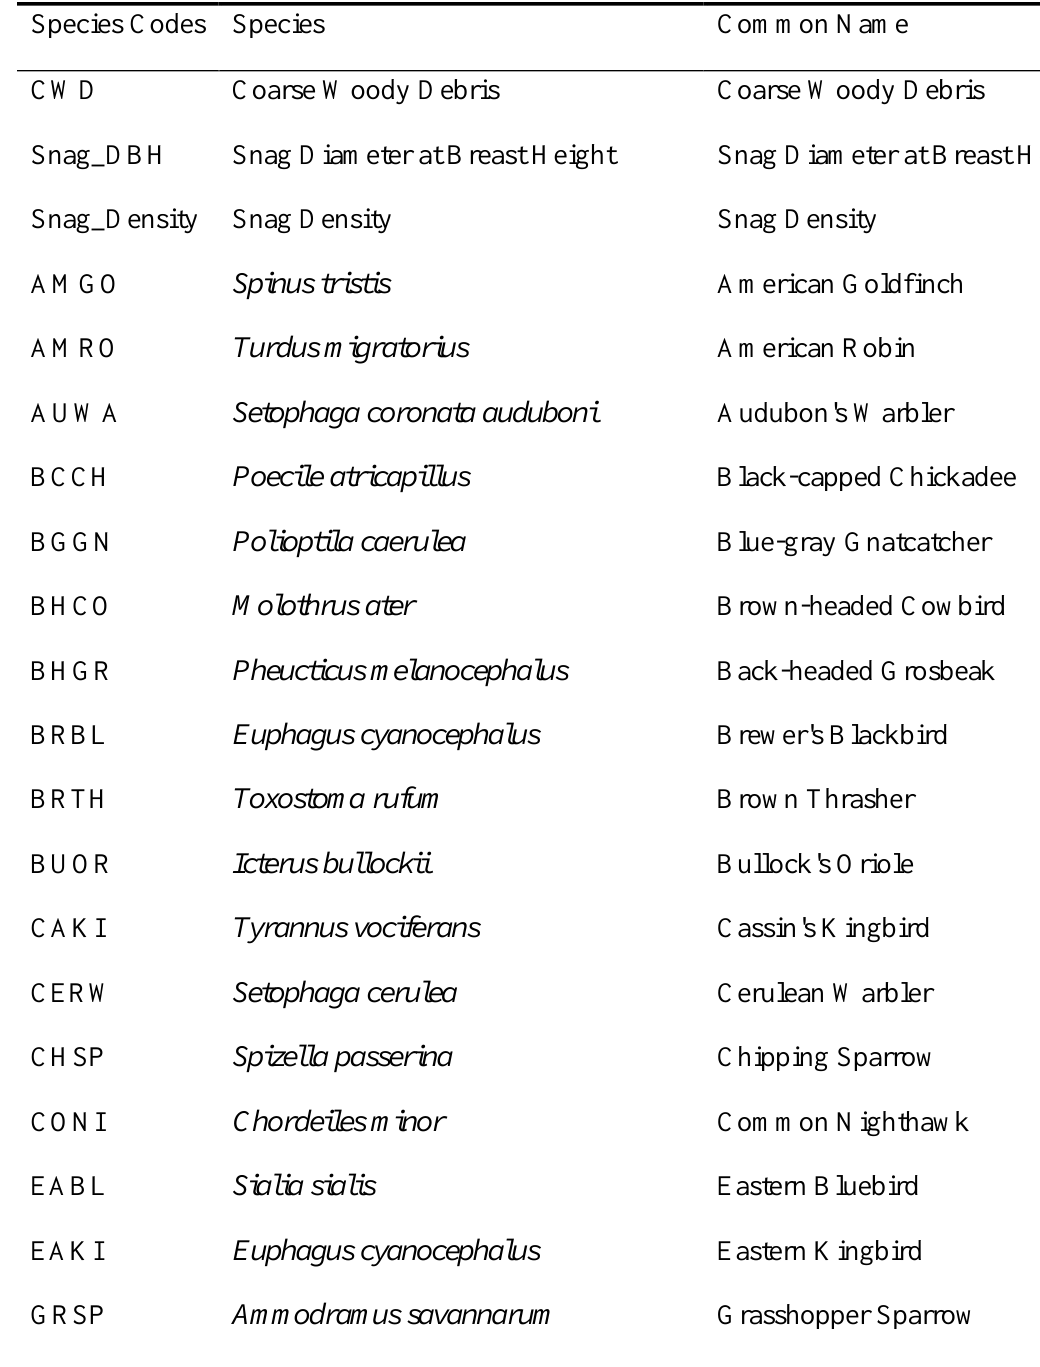
Table A1.4. A list of species codes, species name, and common names used in the ‘Additional Ecosystem Characteristics’ ordination that were found in 2016 within and surrounding the perimeter of the 1989 Fort Robinson wildfire, Nebraska,